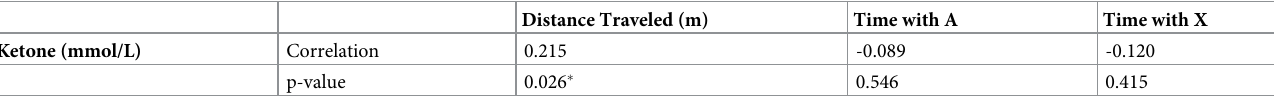
Table 7. Ketone correlation matrix including all rat